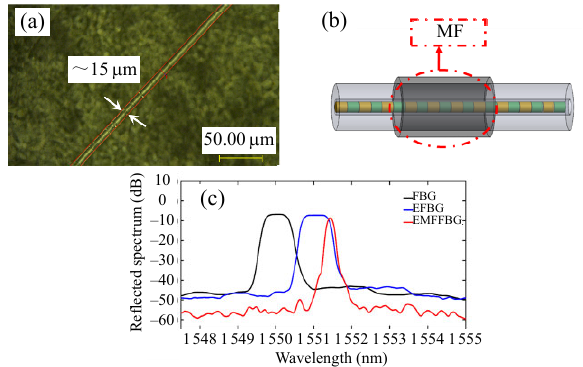
Fig. 2 Preparation and test of FBG-based magnetic field sensor: (a) micrograph of the etched FBG, (b) sensor encapsulation diagram, and (c) spectra before etching, after etching, and filling with